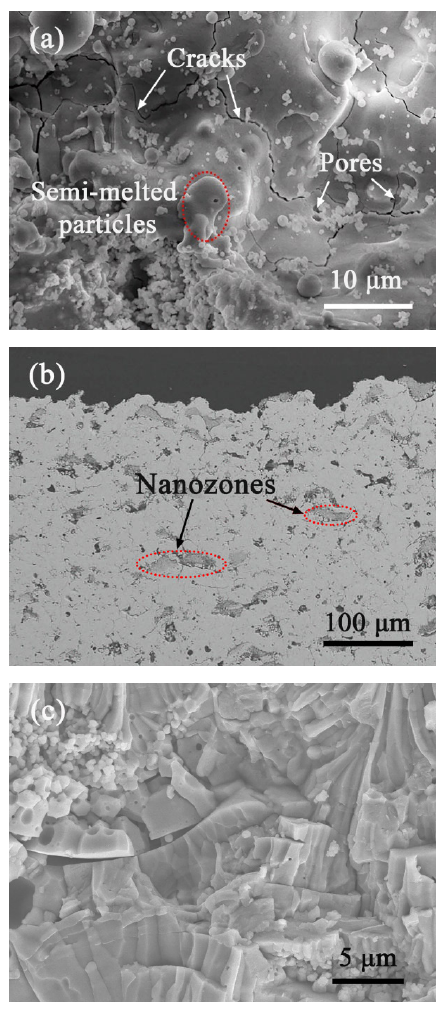
Fig. 1 (a) Surface appearance, (b) cross-section microstructure, and (c) facture-section image of the as-sprayed YSZ